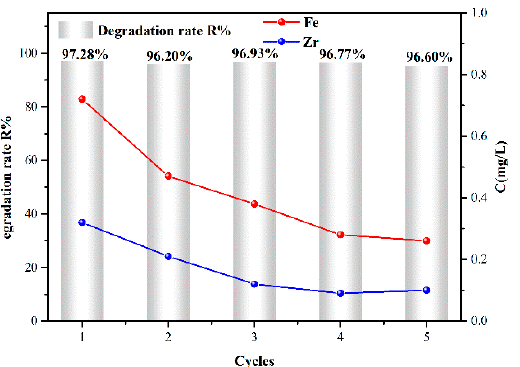
Figure 8. The leaching concentration of iron zirconium ion and degradation efficiency of SMX in five cycles.